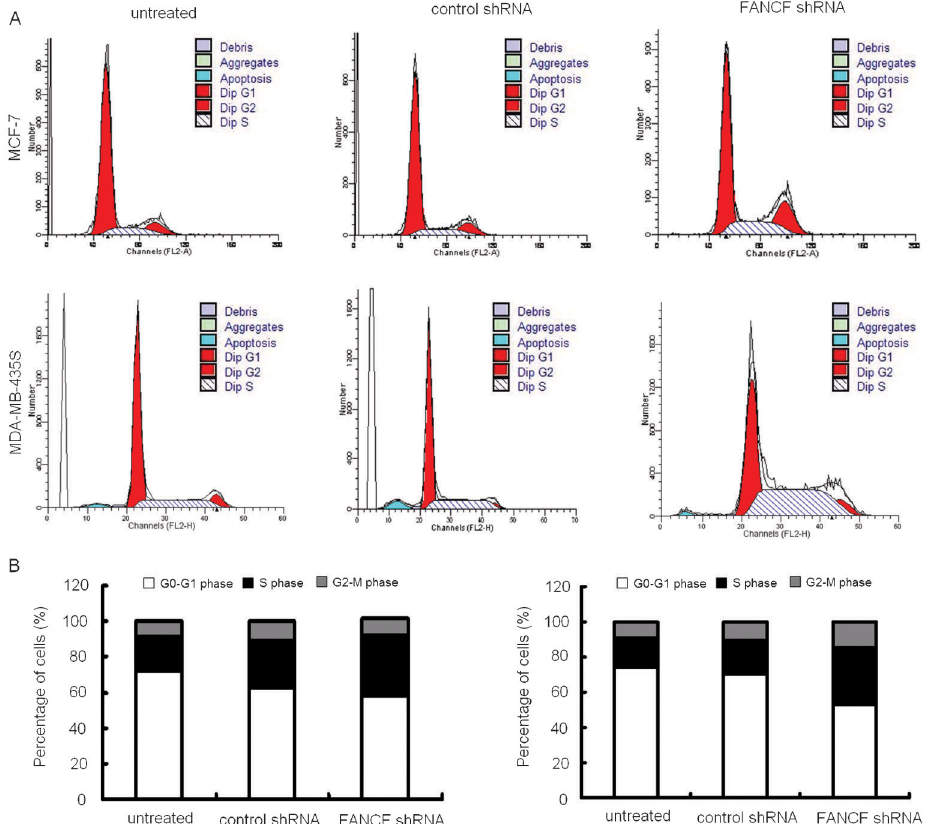
Figure 4. FANCF-shRNA resulted in changes of cell-cycle distribution in MCF-7 and MDA-MB-435S cells. Flow cytometry analysis of MCF-7 and MDA-MB-435S cell cycles after transfection with FANCF shRNA or control shRNA for 48 h. A , One representative experiment is shown. B , Quantitative analysis of different cell phase populations. Data are reported as mean percentages of three independent experiments in